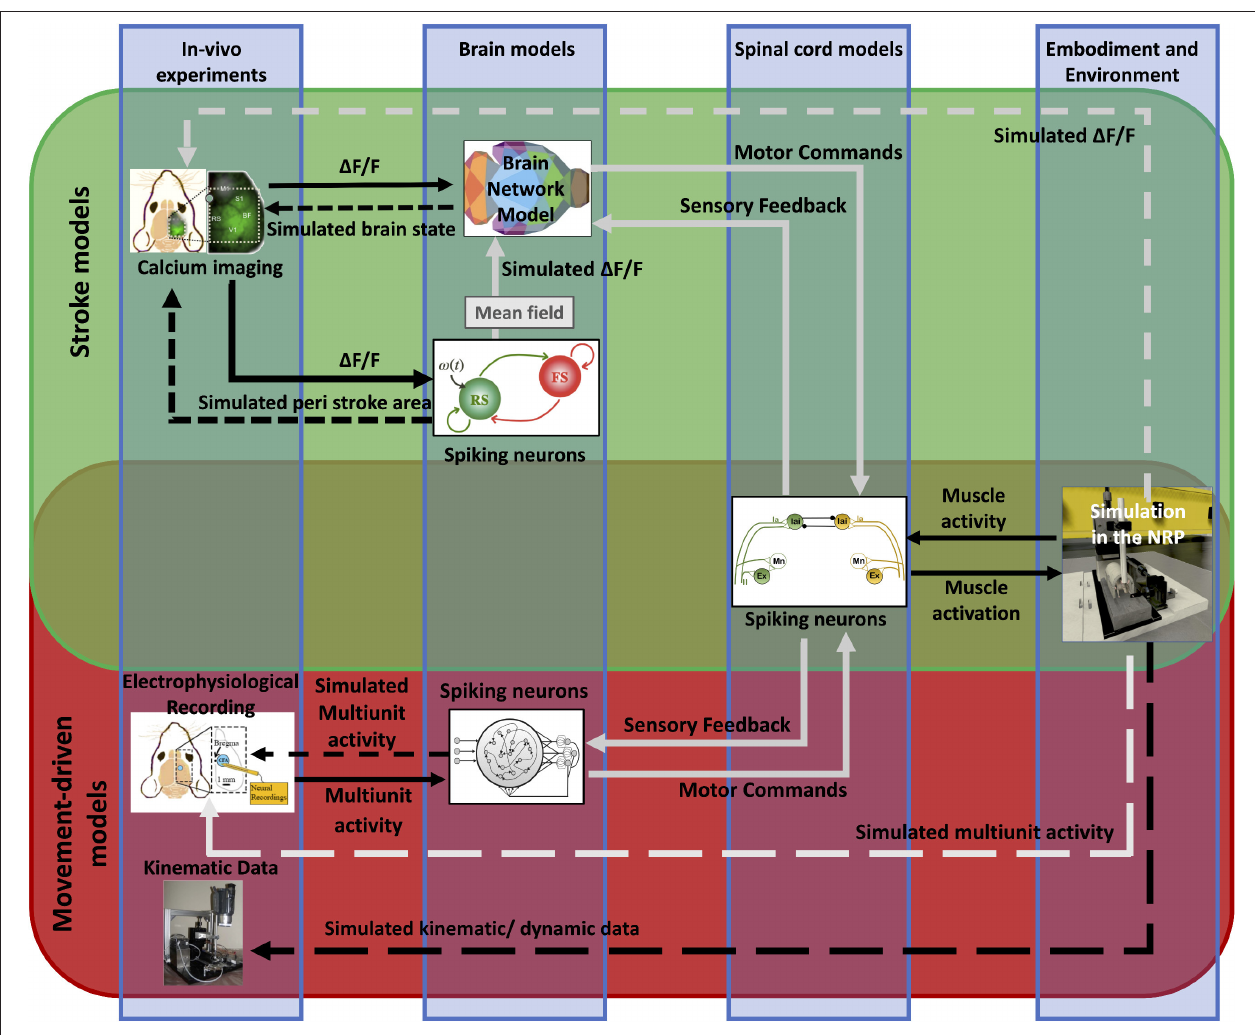
FIGURE 11 | Future perspective of data and simulations. The scheme depicts the approach to build the framework from data to models and back. The workflow from data to models and simulation in the Embodied brain closed loops is shown. The upper, green box shows the Stroke models closed loop, the lower, red box shows the Movement-driven models closed loop. Colored images represent experiment data, brain and spinal cord models, and simulation of the environment (from left to right). Connections between the components are presented as arrows: solid lines represent the output provided to other blocks; dashed lines indicate the output data of the models that are used for comparison with real data for validation. In gray, models and connections that are still under development. The overlapping green and red region pictures the future integration of the two pipelines, and in particular of the brain models within the